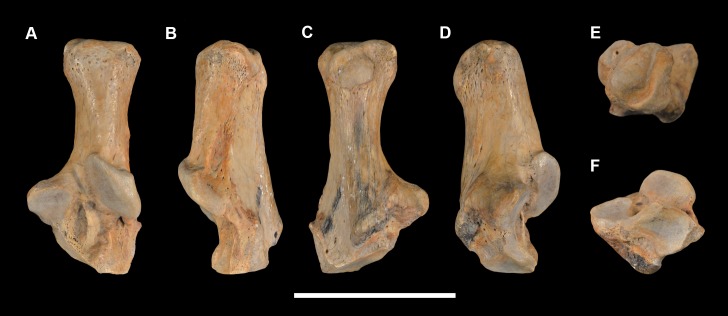
Left calcaneum of Periptychus carinidens (NMMNH P-48429).(A) dorsal view; (B) lateral view; (C) plantar view; (D) medial view; (E) distal view, (F) anterior view. Scale bar: 30mm.